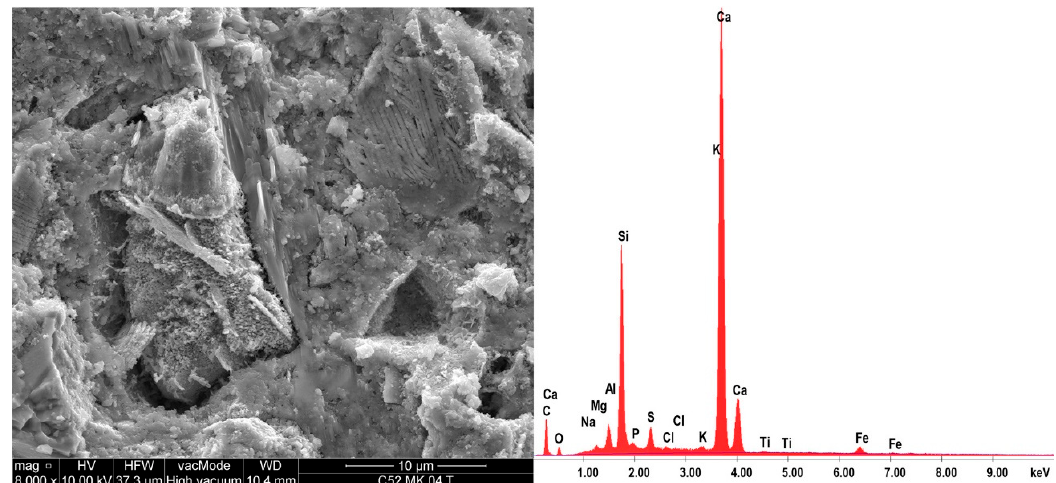
Figure 11. EDS spectra of the C52MS sample together with the SEM image of the area analyzed.